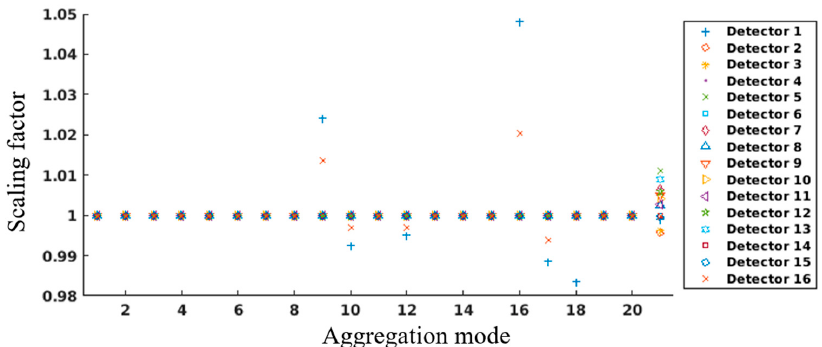
Figure 9. Scaling factors for correcting LGS gain coefficient stored in the NOAA-20 VIIRS DNB LGS Gains LUT.